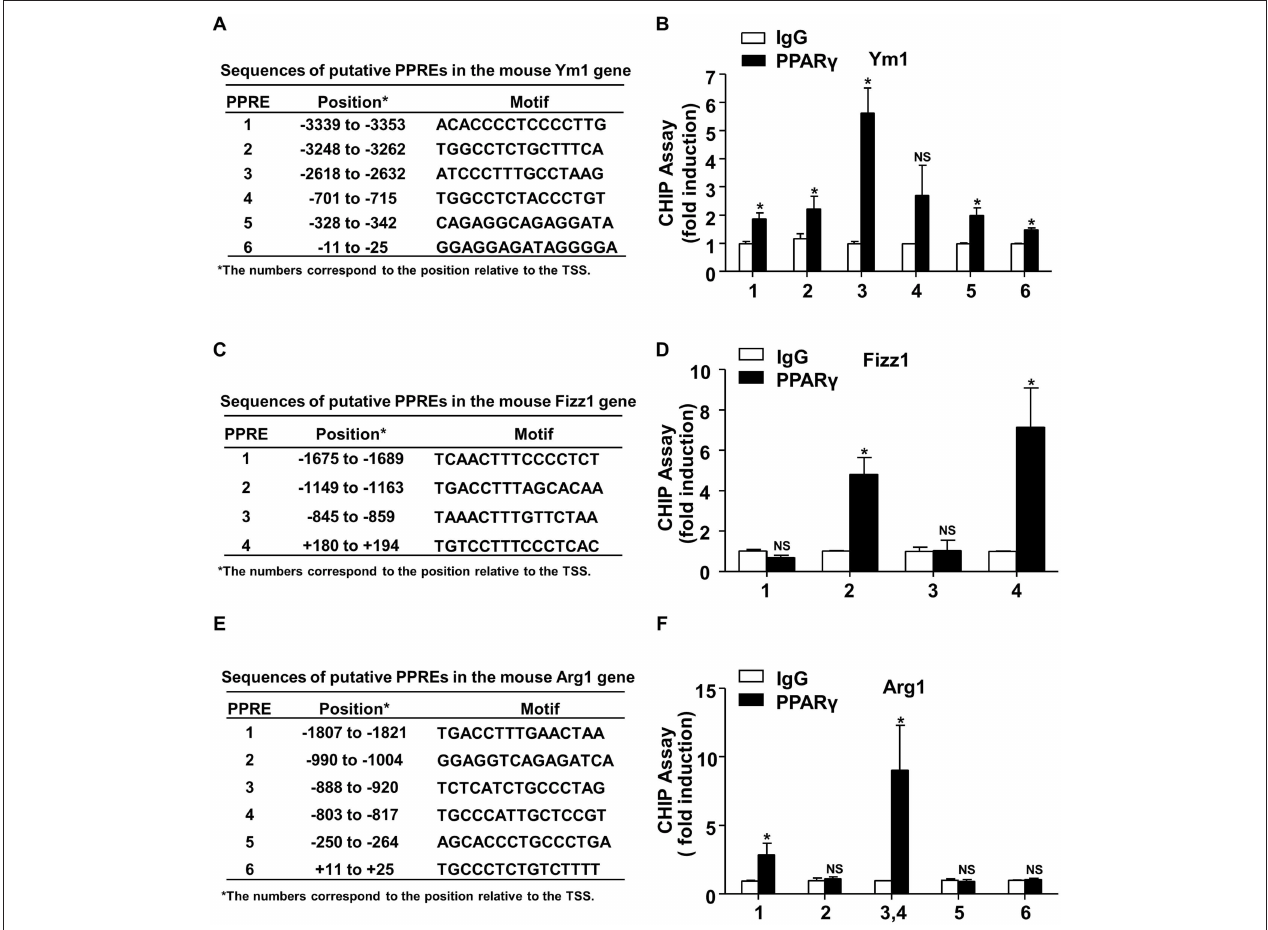
FIGURE 5 | Identification of PPAR γ -binding sites in the mouse Ym1, Arg1, and Fizz1 promoters. (A,C,E) Putative PPREs in the mouse Ym1, Fizz1, Arg1 gene promoters are listed with their positions in relation to TSS and core sequences. (B,D,F) ChIP assays were performed in RAW264.7 cells overexpressing PPAR γ with the use of anti-PPAR γ antibody or IgG as control. PPRE binding was quantified by using qPCR with the primers flanking the putative PPREs in the Ym1 (B) , Fizz1 (D) , Arg1 (F) gene promoters. The PCR results were expressed as fold change compared with IgG control. Data were shown as mean ± SEM, n = 3–8, * P < 0.05 vs. IgG control; NS, not